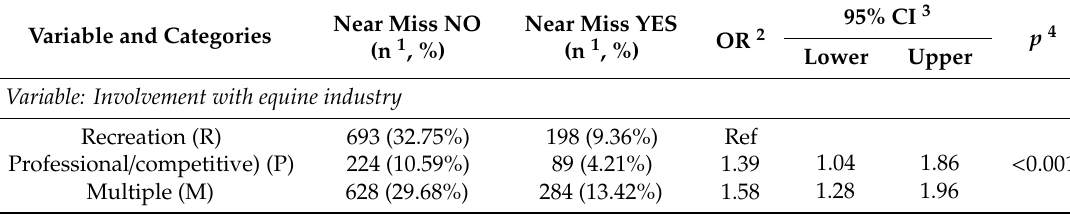
Table 5. Results of univariate logistic regression analyses of the significant association between the variable ‘involvement with equine industry’ and whether a near miss was